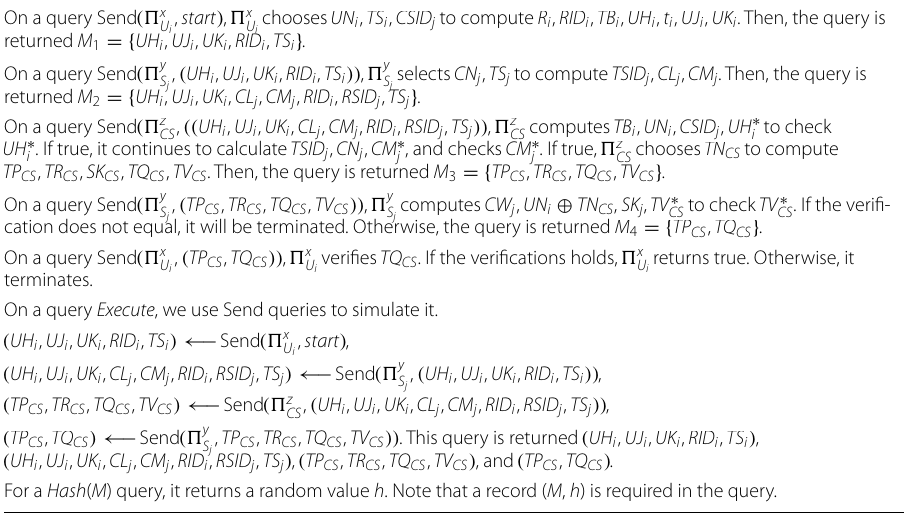
Table 3 Simulation of